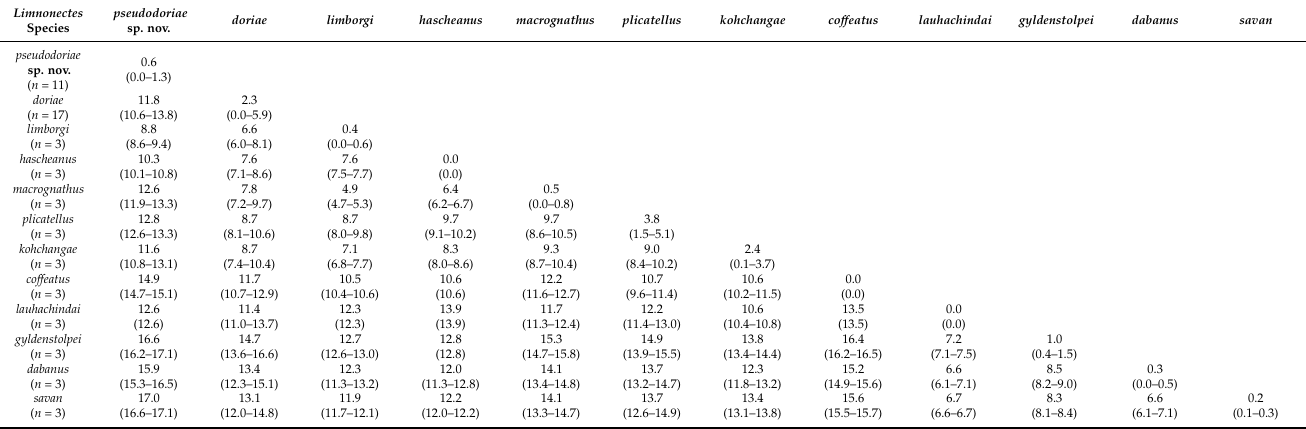
Table 1. Percentage uncorrected pairwise sequence divergences ( p -distances) in the mitochondrial 16S rRNA gene of Limnonectes pseudodoriae sp. nov . and related species. Limnonectes pseudodoriae Species sp. nov. pseudodoriae sp. nov. ( n =11)